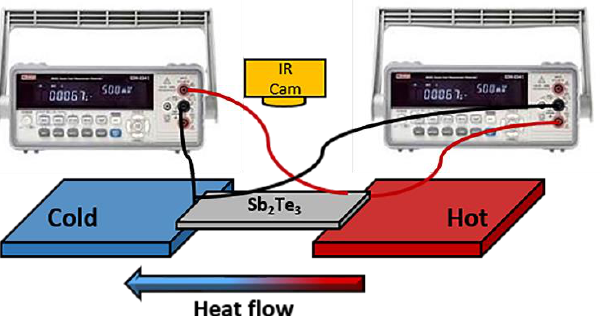
Figure 2. Experimental setup for output performance measurement of a single planar Sb 2 Te 3 film.